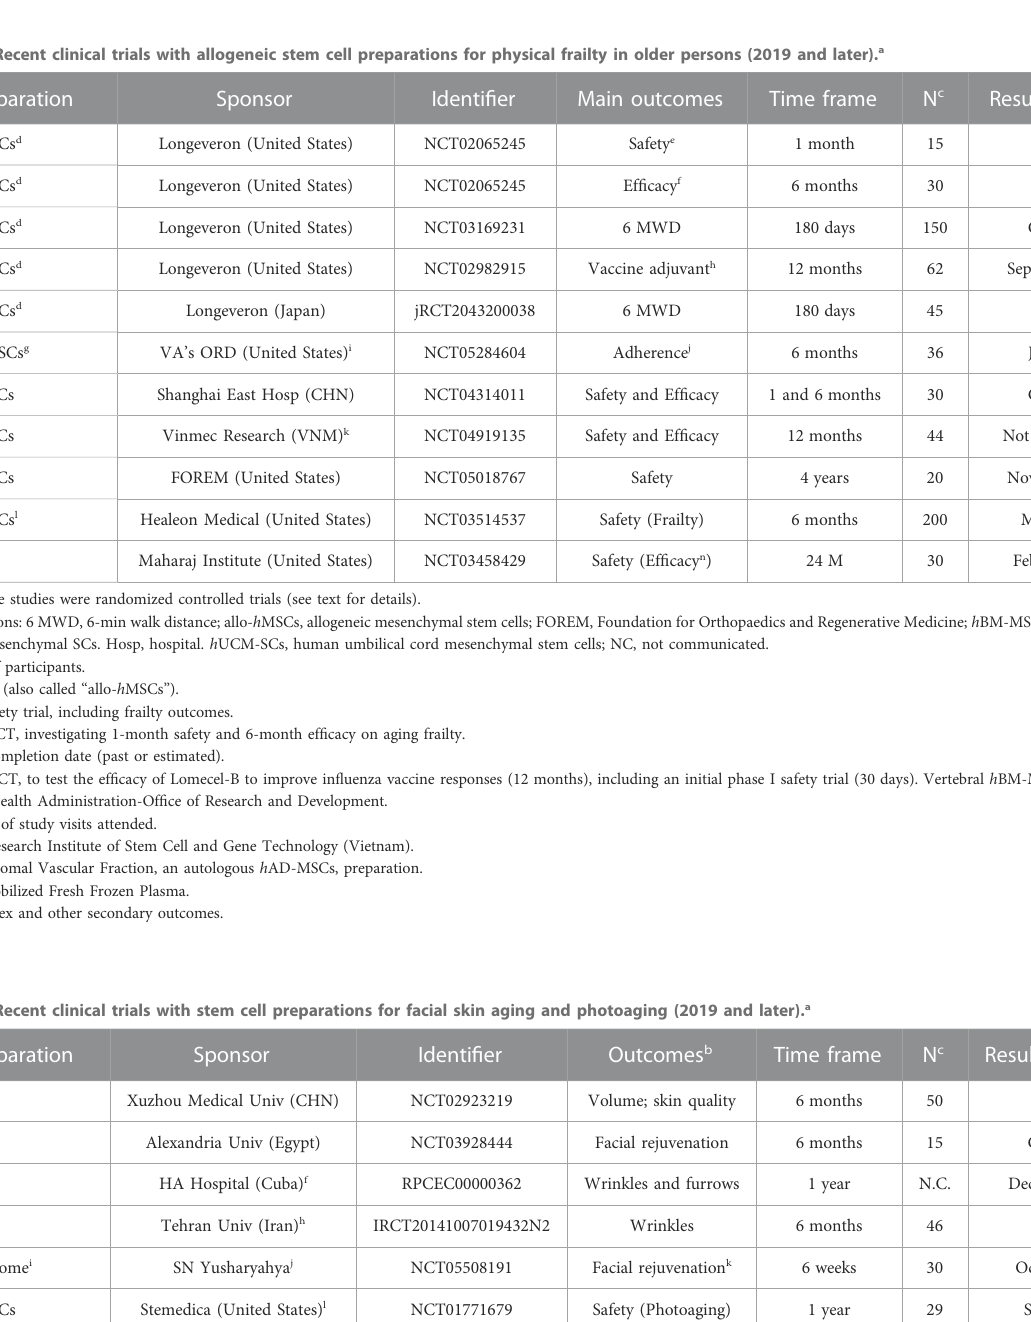
TABLE 1 Recent clinical trials with allogeneic stem cell preparations for physical frailty in older persons (2019 and later). a